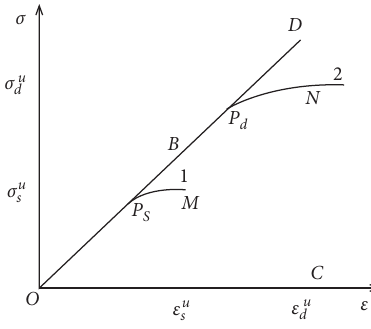
Figure 4: Static and dynamic constitutive relation curve of